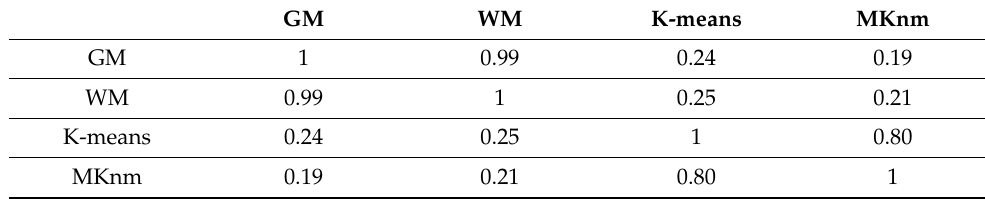
Table 2. Correlation coefficients (R) of ABLH determined by LiDAR-based